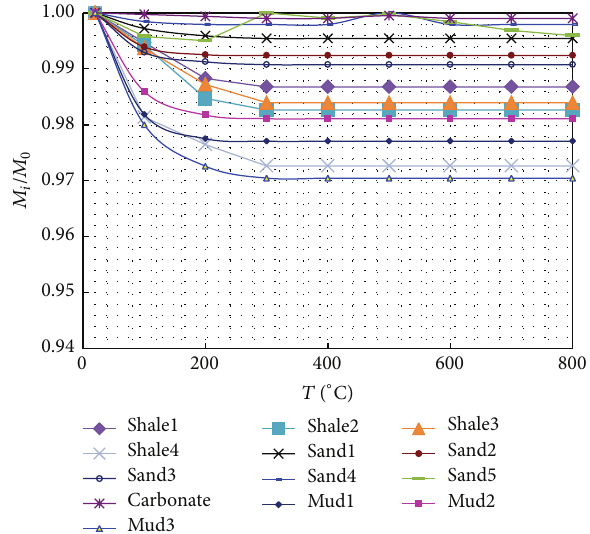
Figure 2: Normalized mass as a function of treatment temperature for all the samples.